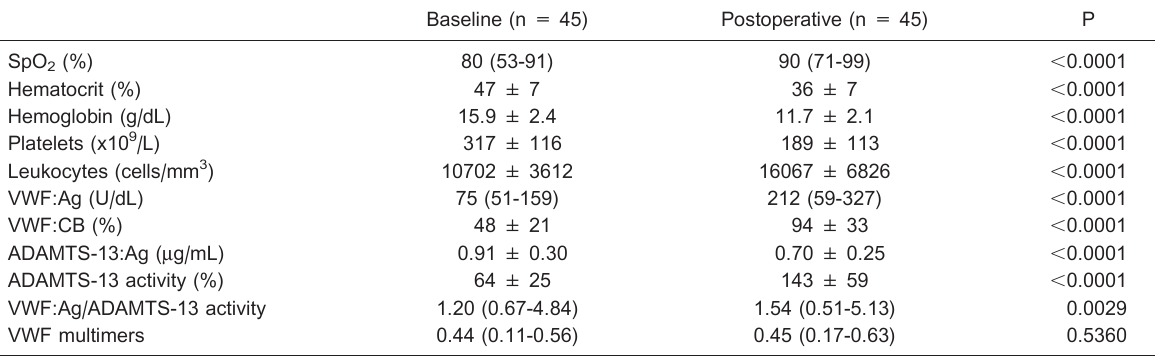
Table 3. Postoperative changes in laboratory parameters compared with